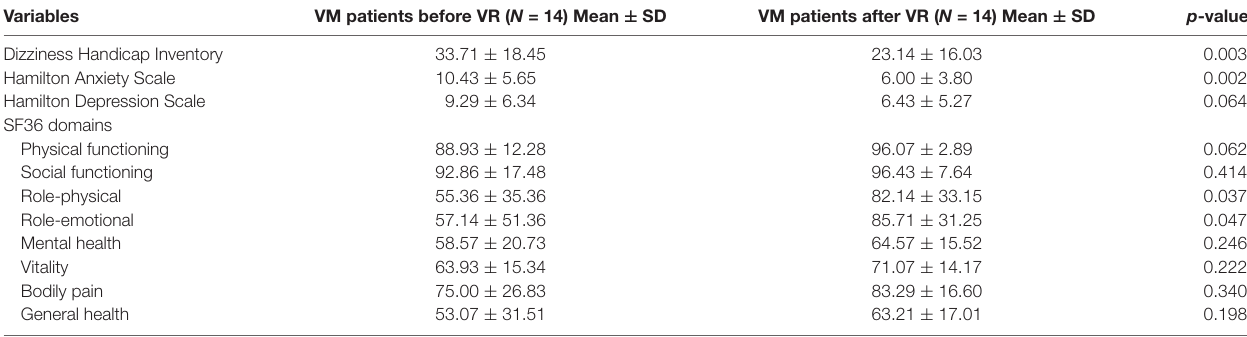
TABLE 2 | The clinical assessment of VM patients before and after vestibular rehabilitation (VR).